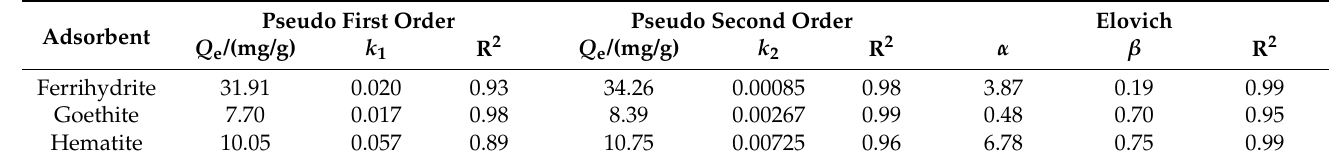
Table 2. Fitting results of the adsorption kinetics model of iron